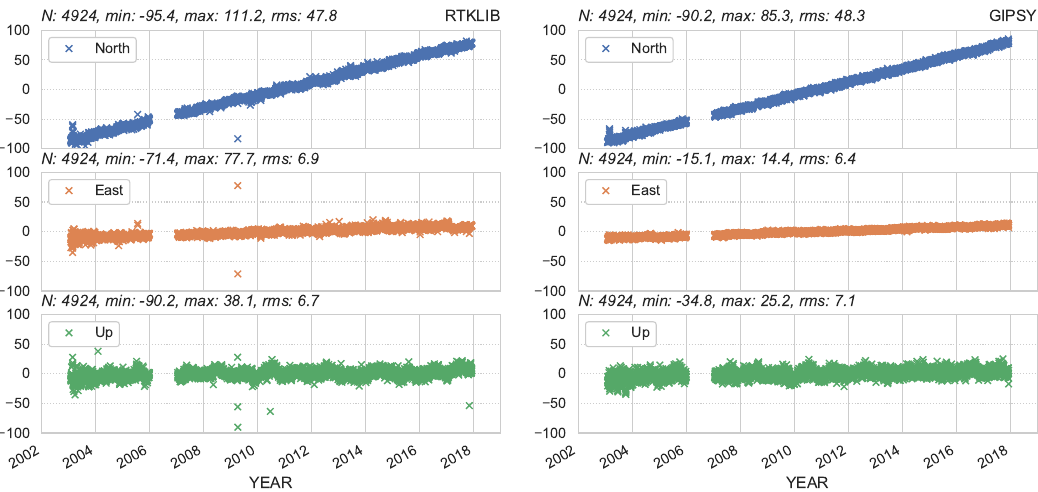
Figure 7. Coordinate time series at Aboa in terms of local displacements in the North, East and Up directions with respect to the mean coordinates of the time series for both solutions: RTKLIB ( left ) and GIPSY ( right ) [unit: mm].